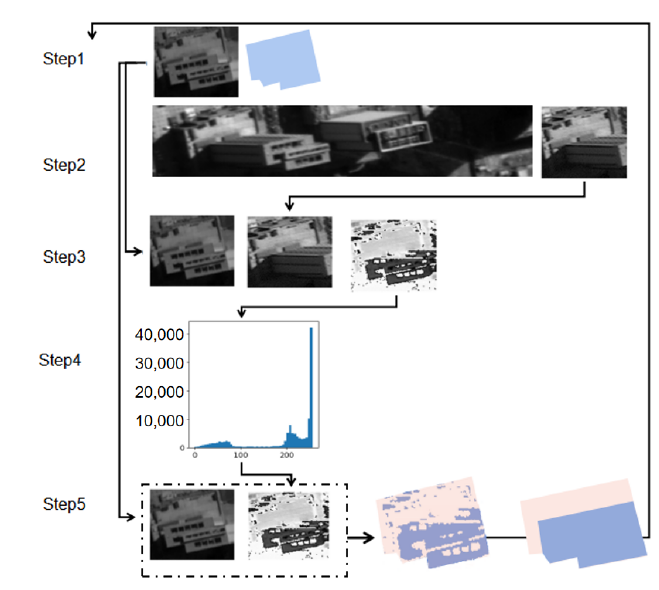
Figure 10. Podium Segmentation workflow.